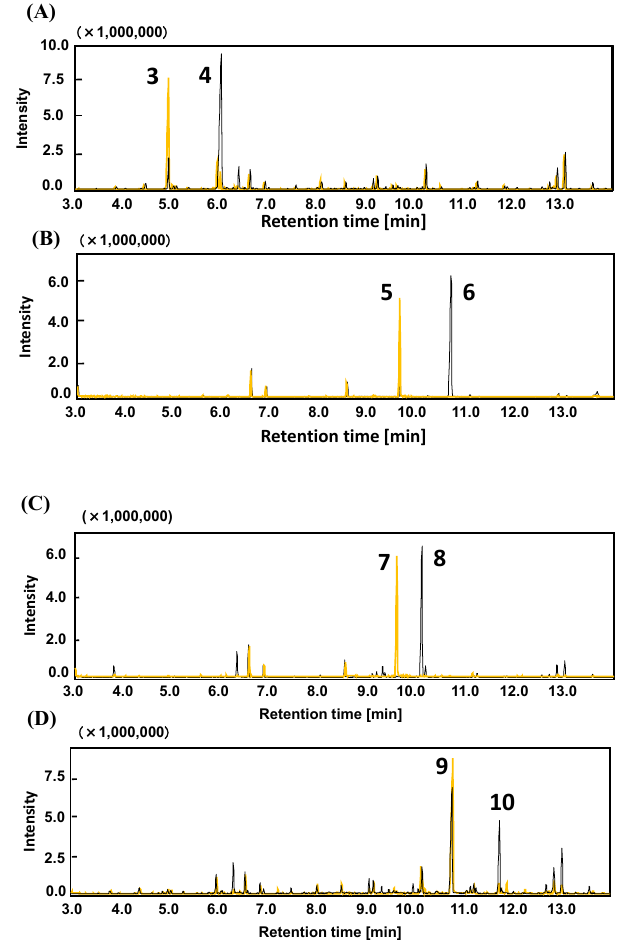
Figure 4. Conversion of bezylaldehyde ( A ), vanillin ( B ), isovanillin ( C ), and syringaldehyde ( D ) by E. coli cells carrying pKSBzfC (black line) or E. coli cells carrying pBluescriptKS + (yellow line). Peak 3, benzyl alcohol; 4, benzoic acid; 5, vanillyl alcohol; 6, vanillic acid; 7, isovanillyl alcohol, 8; isovanillic acid; 9, syringic alcohol; 10, syringic acid. The products were derivatized with MSTFA and identified by comparing the retention time and mass spectra of authentic standards. m / z values of each peak are listed in Supplemental Table